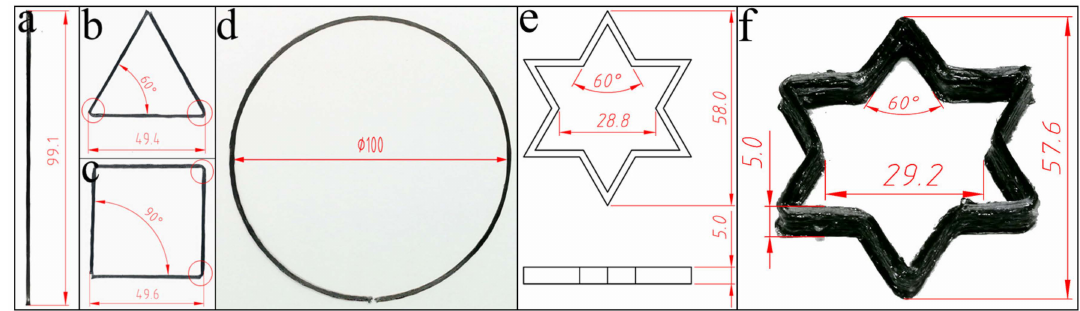
Figure 10. The printing tests and corresponding dimensions of ( a ) line, ( b ) triangle, ( c ) quad, and ( d ) circle and the comparison between the dimensional di ff erences in the ( e ) original 3D model and ( f ) printed pre-formed